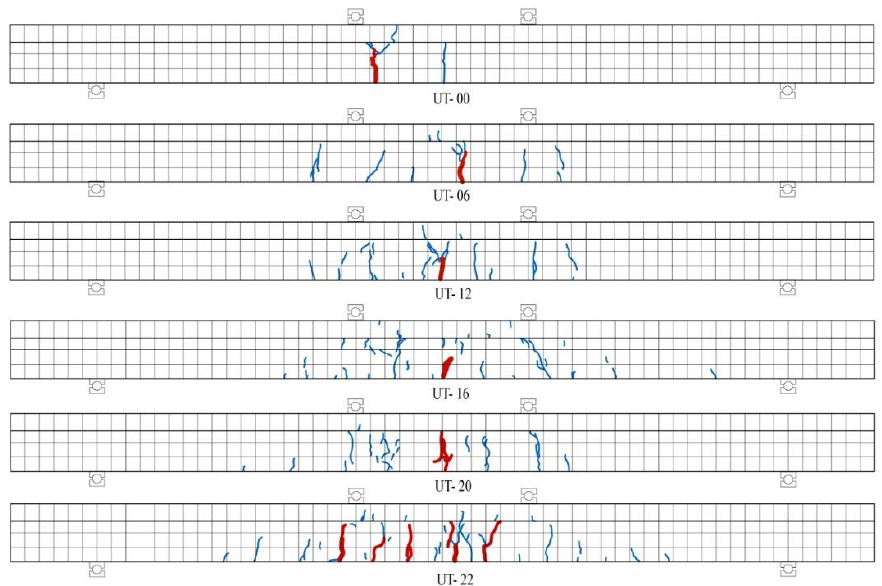
Figure 9. Cracking pattern of all beams after loading tests.